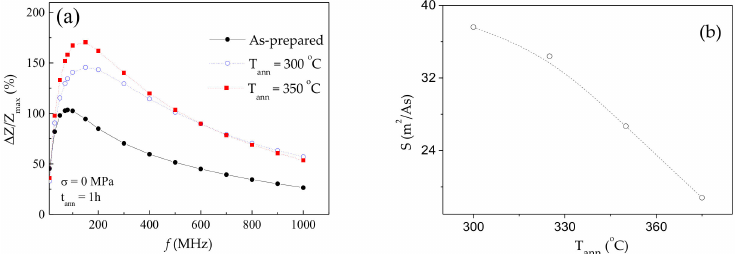
Figure 4. ∆ Z / Z max (f) dependence of as-prepared and annealed at T ann = 300 ◦ C and T ann = 350 ◦ C Co 69.2 Fe 3.6 Ni 1 B 12.5 Si 11 C 1.2 Mo 1.5 microwires ( a ) and dependence of DW mobility, S , on annealing temperature, T ann ( b